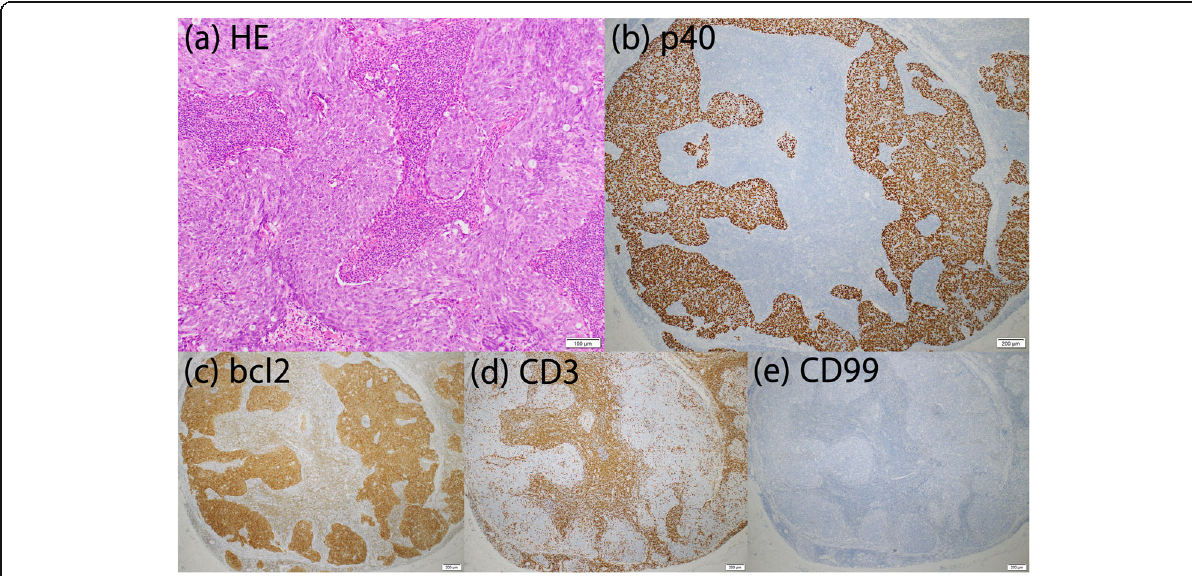
Fig. 2 Case 2. Results of HE staining and immunohistochemical analysis. a HE staining showed that the tumor cells had edematous large and round nuclei and formed a solid corded net on the background of dense lymphocyte infiltration. Thymic disease was positive for b p40, and c Bcl2 and CD5, while infiltrated lymphocytes were positive for d CD3 and negative for e